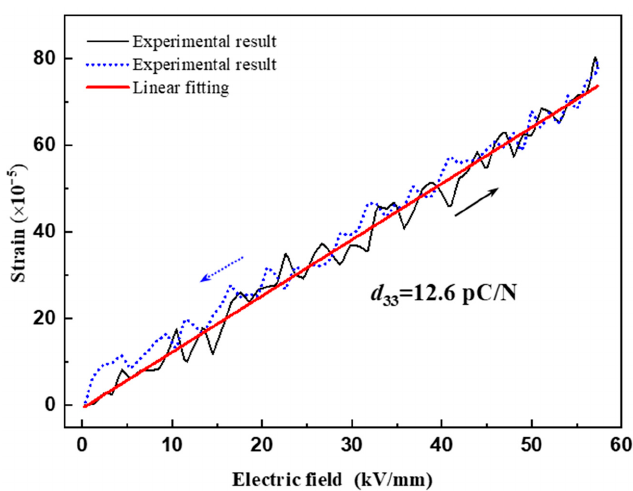
ing AlN with ScAlN [31].